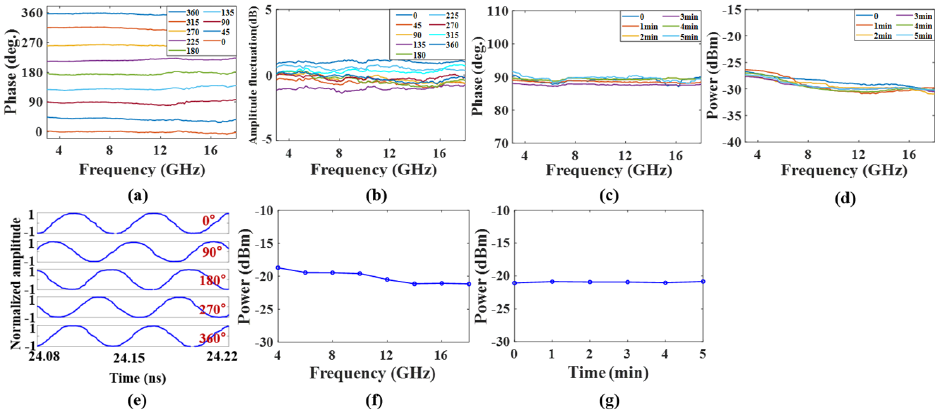
Figure 4. The phase ( a ) and power ( b ) response of the fundamental frequency mode; the phase drift ( c ) and power ripple ( d ) within 5 min; ( e ) the phase shift of the doubled frequency mode within 360° when the LO signal is 8 GHz; ( f ) the power change in the doubled frequency mode when the LO signal changes at 2–9 GHz; ( g ) the power change of in doubled frequency mode within 5 min when the LO signal is 8 GHz.